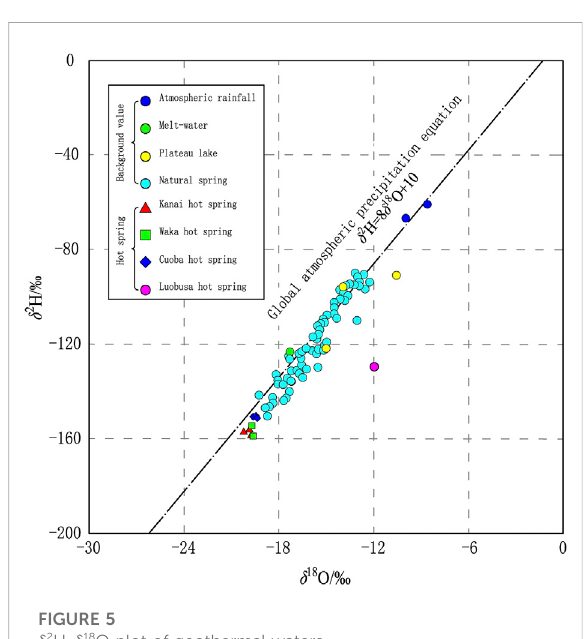
FIGURE 4 δ 13 C-HCO 3 plot of geothermal waters.